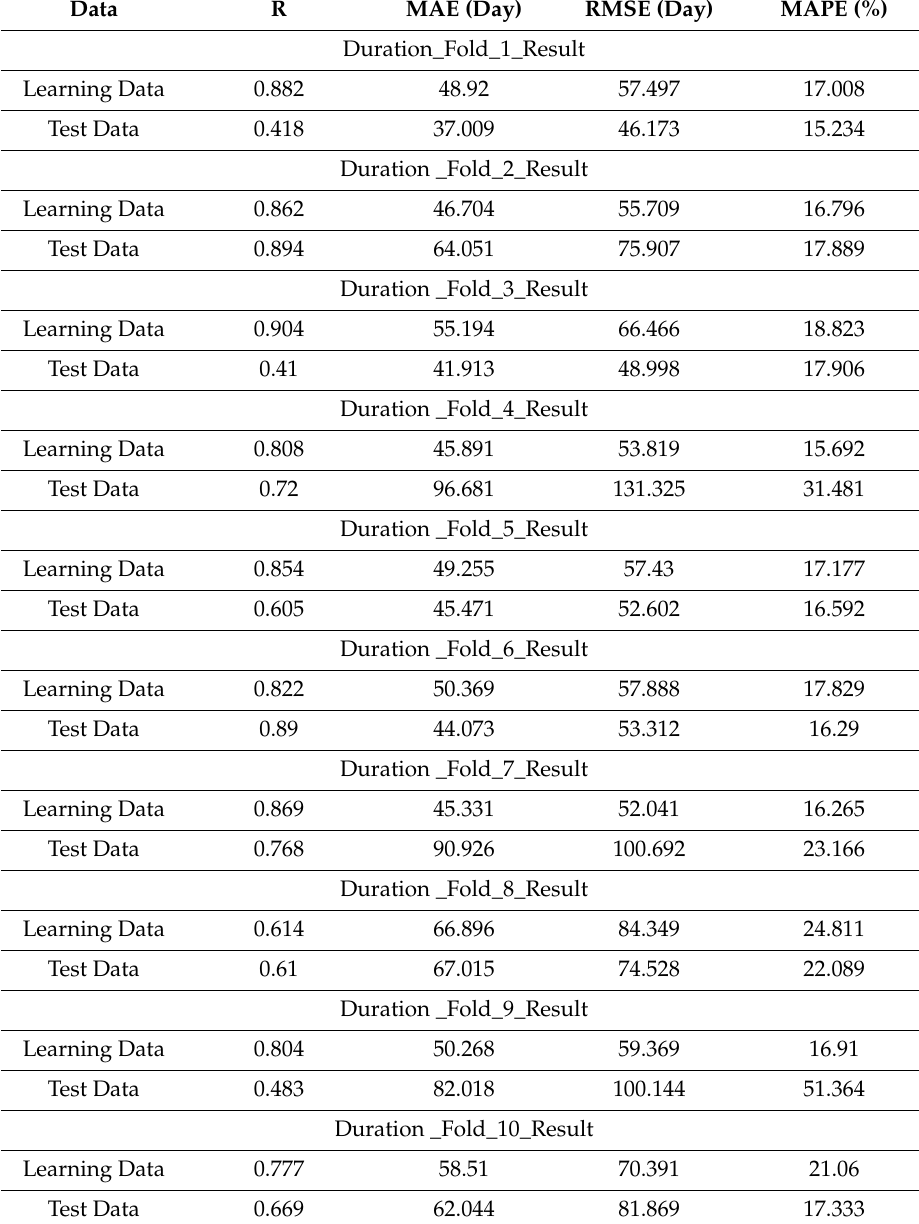
Table 5. Model stability test after parameter optimization using